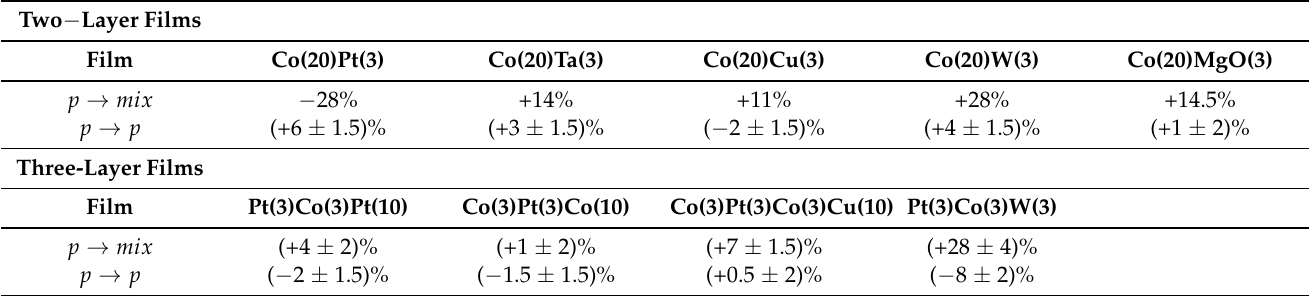
Table 1. Magnetic contrast of the SHG intensity for various planar structures measured in reflection in the scheme of the longitudinal MOKE ( p → mix polarization combination) and in the forbidden geometry ( p → p polarization